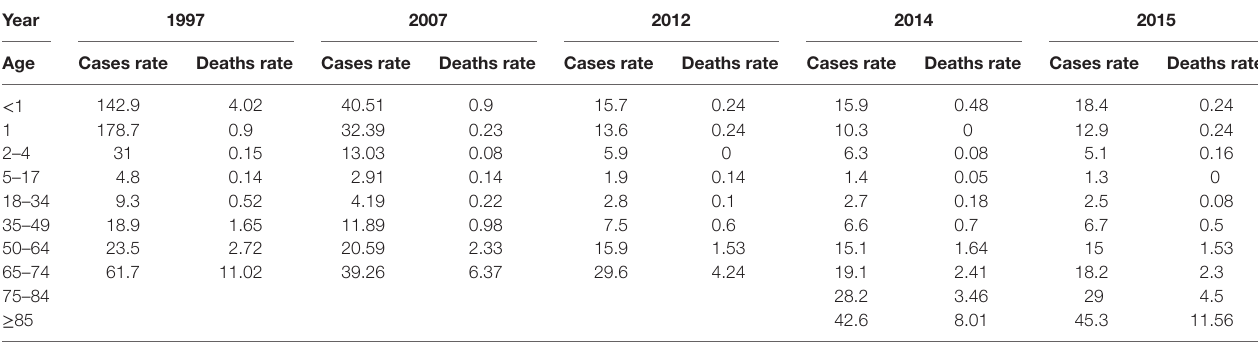
TAbLe 1 | Occurrence of pneumococcal diseases from 1995 to 2015 as reported a by the Centers for Disease Control. Year 1997 2015 Age Cases rate Deaths rate Cases rate Deaths rate Cases rate Deaths rate Cases rate Deaths rate Cases rate Deaths